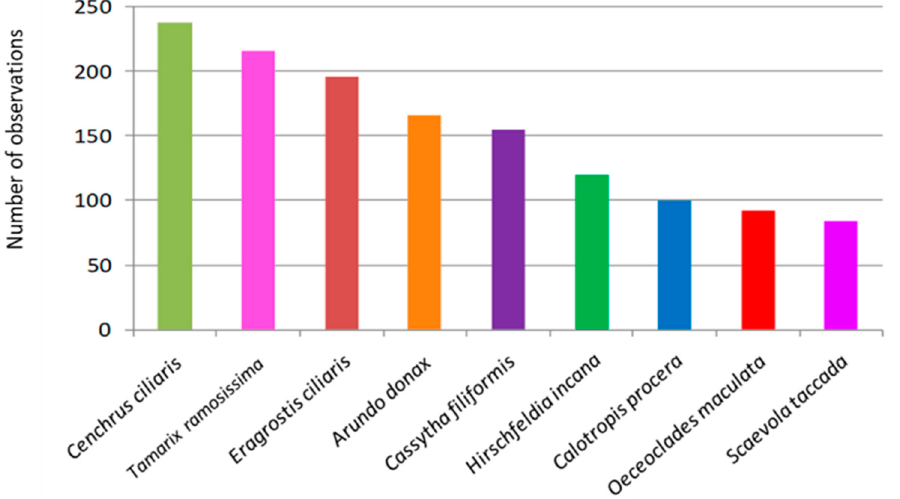
Figure 5. Number of observations of invasive species growing on coastal dunes.